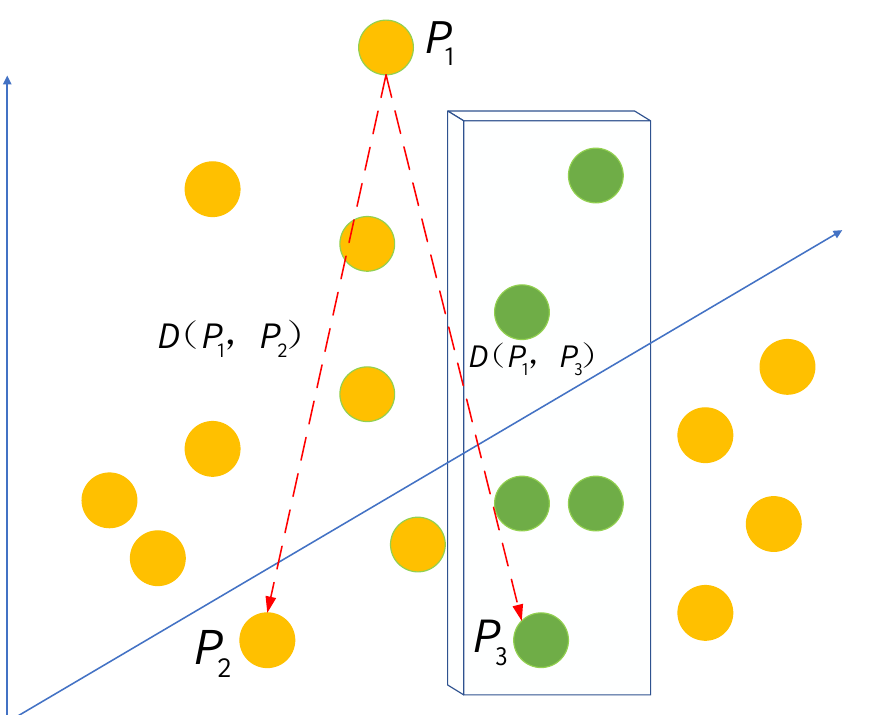
Figure 5. 2D illustration of A-FPS.